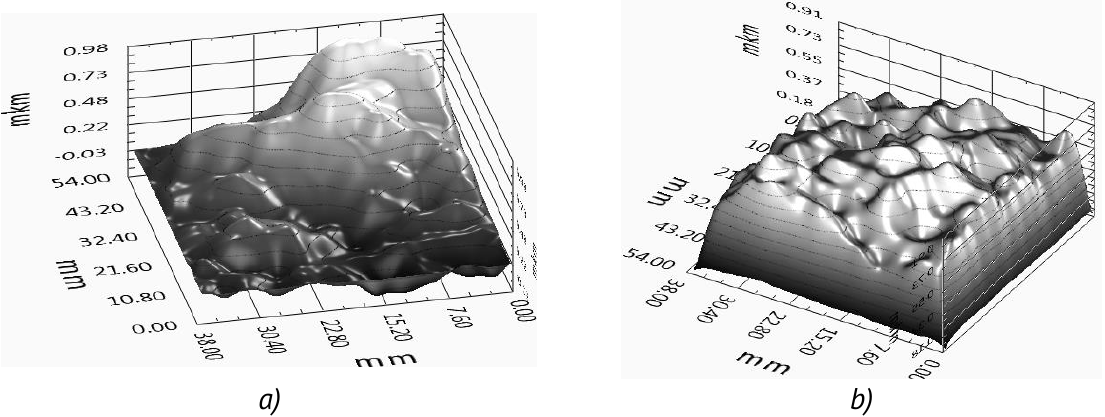
Figure 5. Profiles of deformation of a concrete sample with small marble chips: a - initial sample; b - the same sample subjected to shock